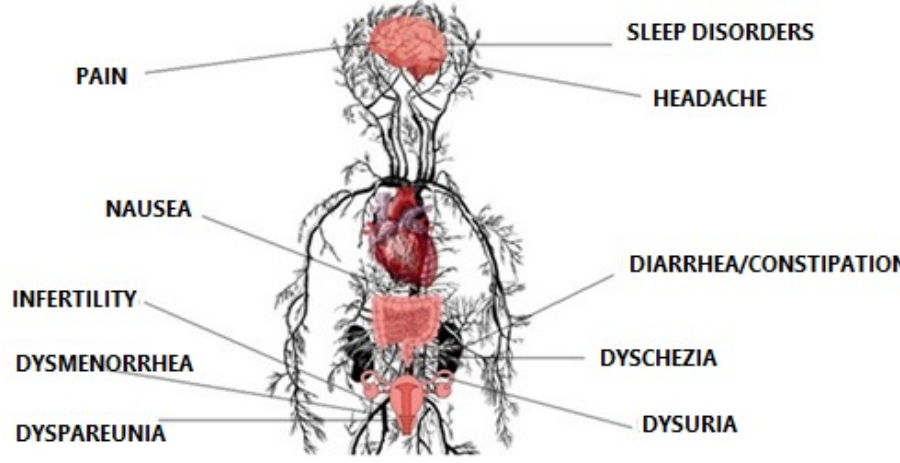
Figure 1. Physical symptoms of endometriosis.